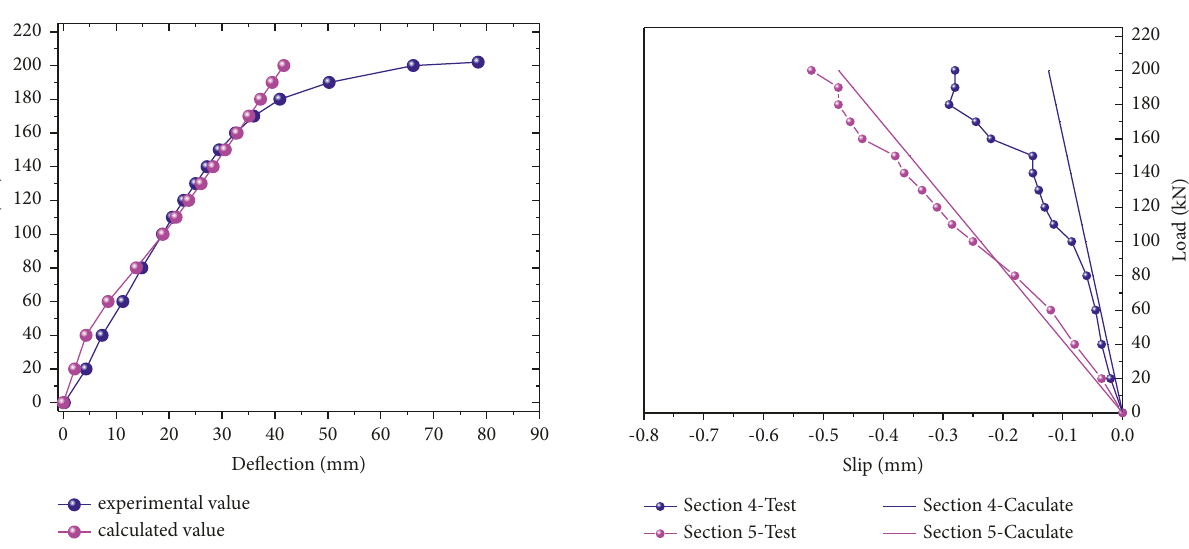
Figure 7: Deflection of overhanging beam under loads.